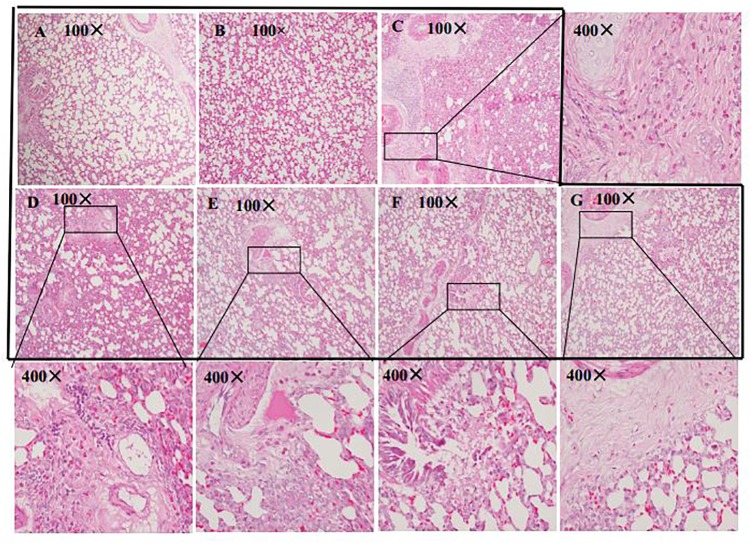
Histological changes in left lung tissue in guinea pigs by HE staining (original magnifications 100 and 400×). (A) Normal control; (B) HSYA blank; (C) OVA; (D) OVA+50 mg/kg HSYA; (E) OVA+75 mg/kg HSYA; (F) OVA+112.5 mg/kg HSYA; (G) OVA+3 mg/kg DXM.